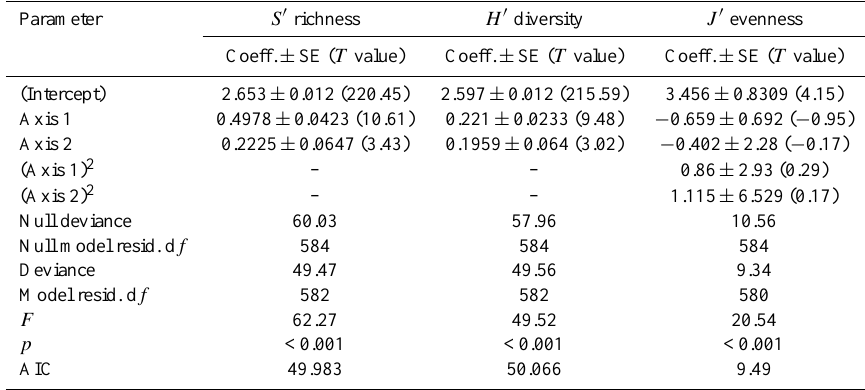
Table 1. GLMs for species richness S (cid:48) , diversity H (cid:48) and evenness J (cid:48)